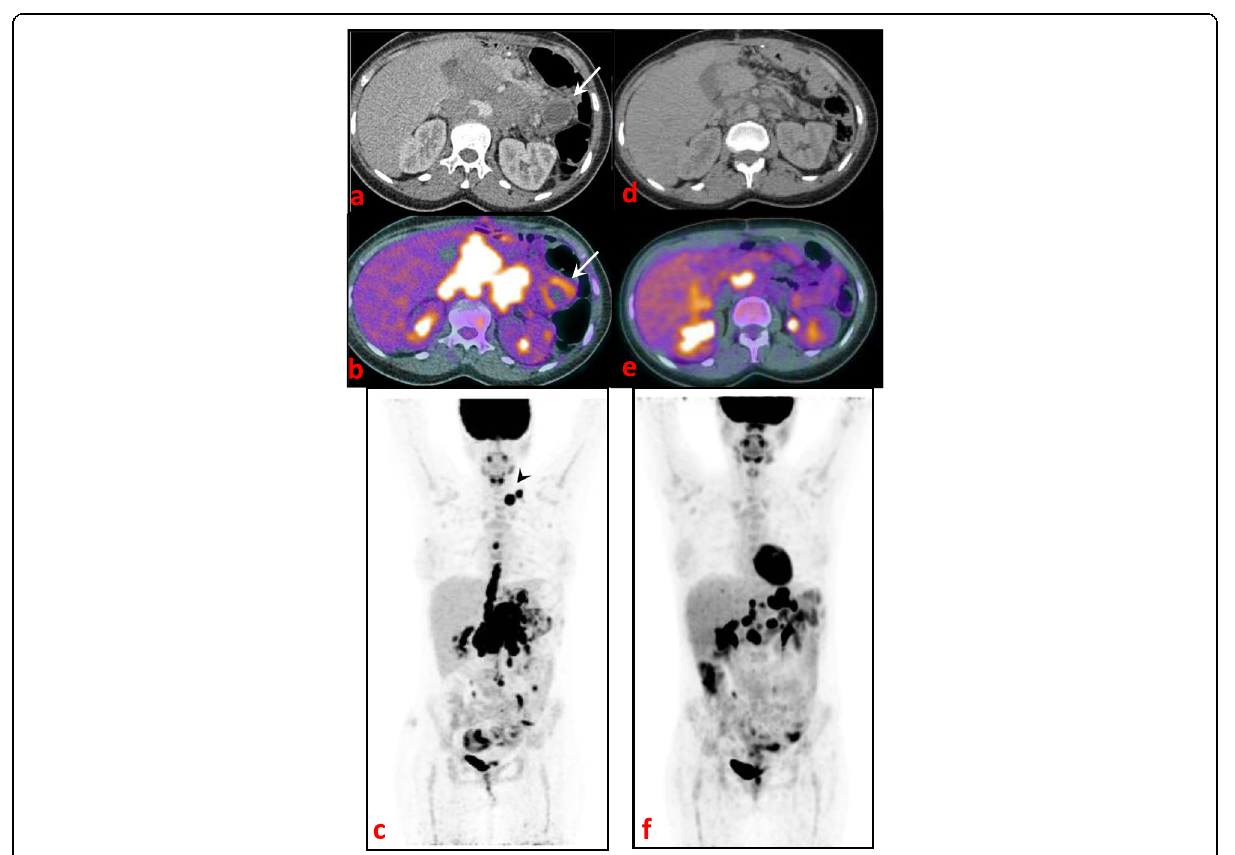
Fig. 5 Axial CT, axial fused, and coronal MIP images for a 60-year-old female presenting with total gastrectomy, splenectomy, and distal pancreatectomy for gastric adenocarcinoma received chemotherapy ( a and b ) showed encysted collection seen at the operative bed with marginal FDG uptake (white arrows). ( c ) Showed left supra-clavicular lymph nodes (black arrow-head), mediastinal, abdominal, and pelvic lymph nodes. ( d , e , and f ) during 3-month interval follow-up after chemotherapy showing resolution of operative bed encysted collection, marked response of the metastatic lymphadenopathy. Thus, final diagnosis approved by clinical and radiological follow-up after